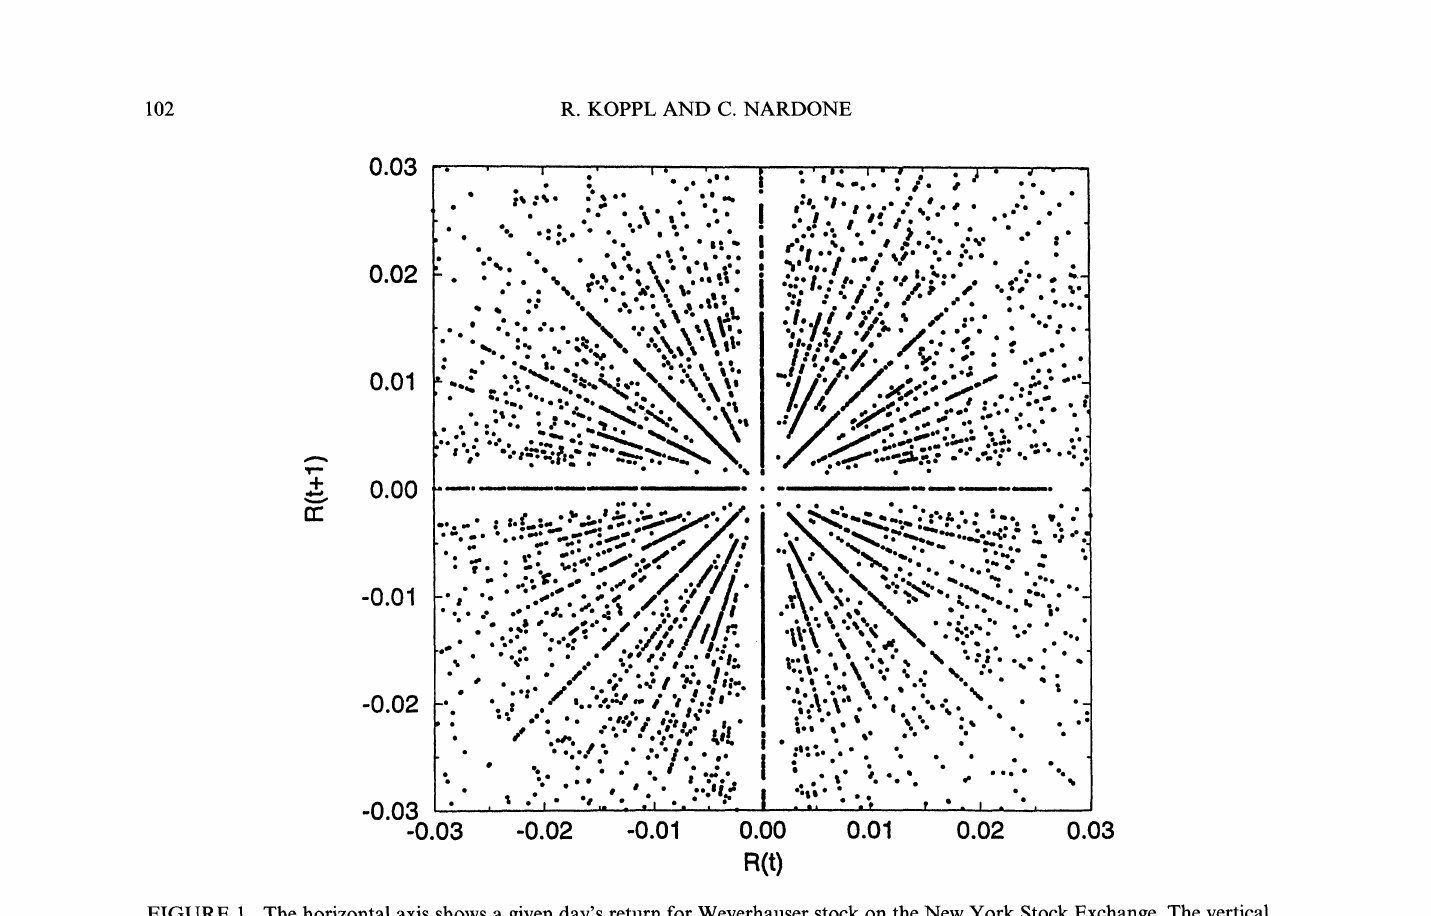
FIGURE The horizontal axis shows a given day’s return for Weyerhauser stock on the New York Stock Exchange. The vertical axis shows the next day’s return. The data cover the period from December 6, 1963 to December 31, 1993. Out of 7558 points, 1212 fall outside the